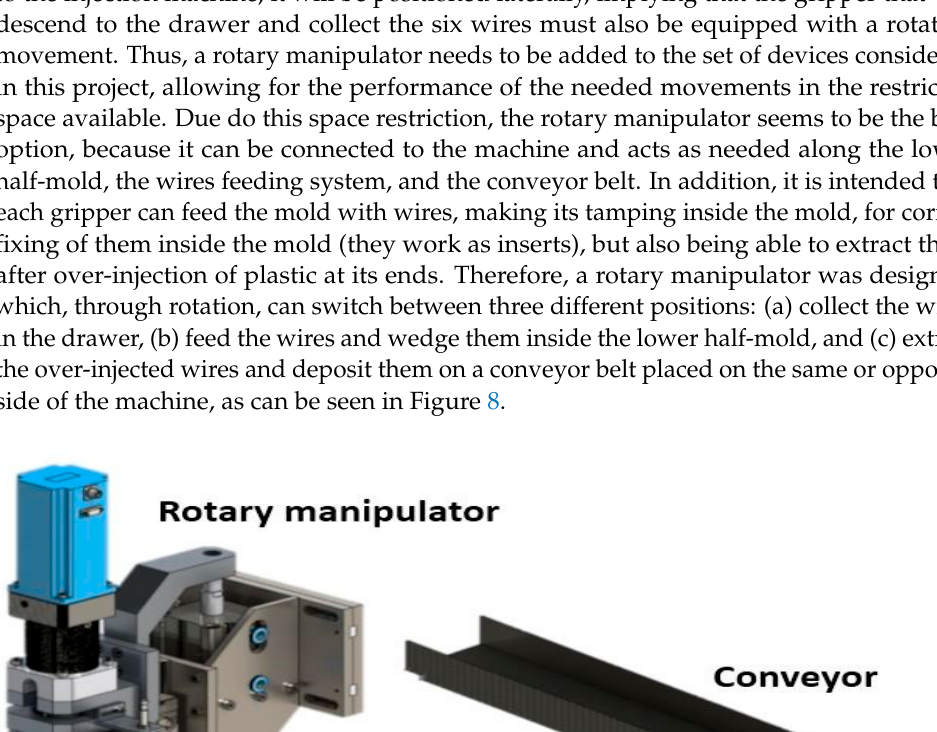
Figure 7. Guide columns and supply system of the wires to the jig in the drawer, respectively.